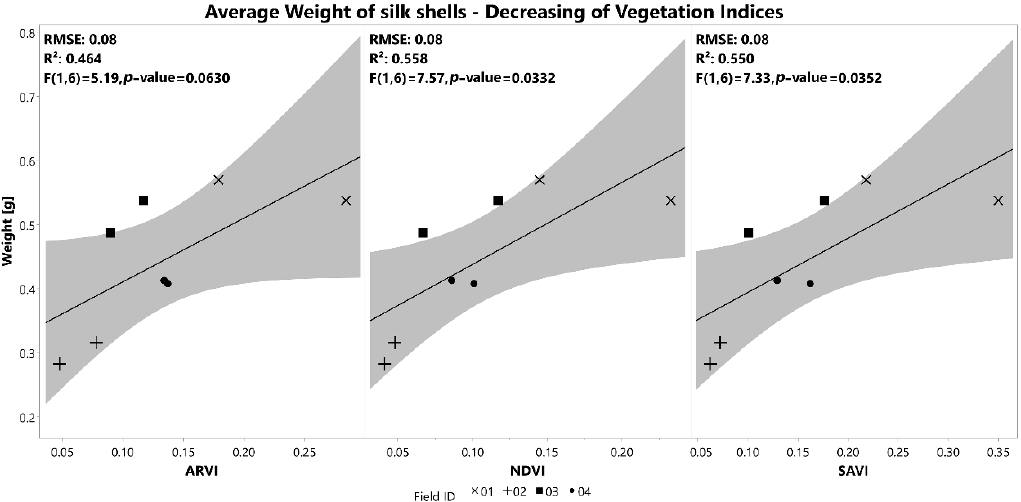
Figure 7. Average weight of silk shell [g] regressions in relation to decreasing vegetation indices during the fifth instar of B. mori . Gray shaded areas represent the confidence interval of regression at 95%.